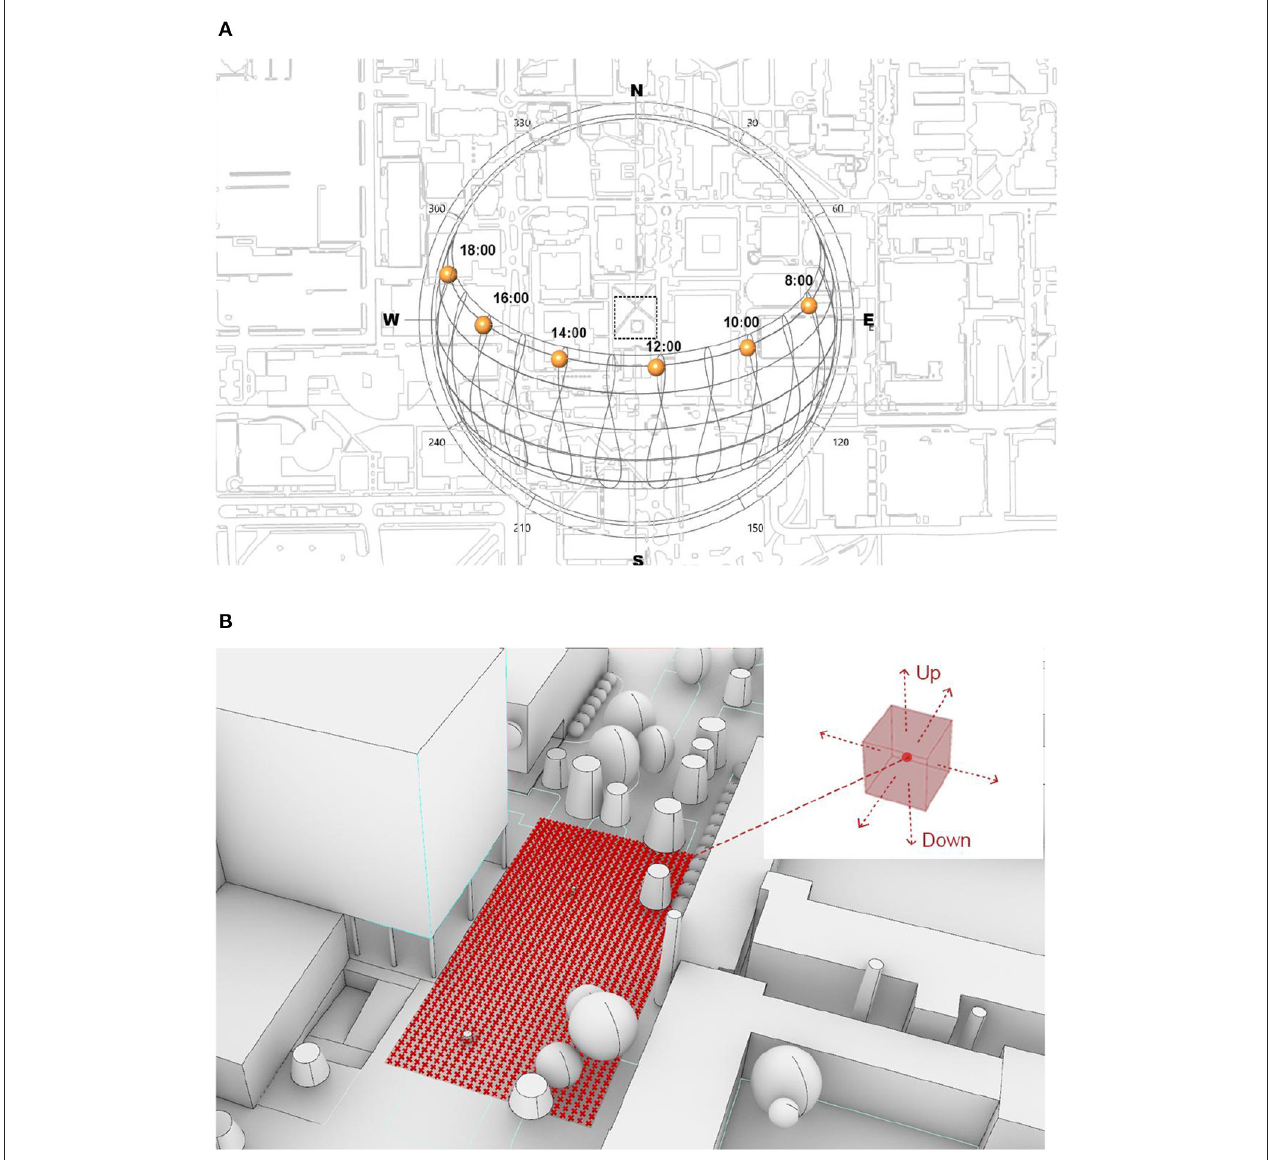
FIGURE 5 | (A) The sun path and sun locations during the measurements; (B) Sample points distribution of Forest Ave site.